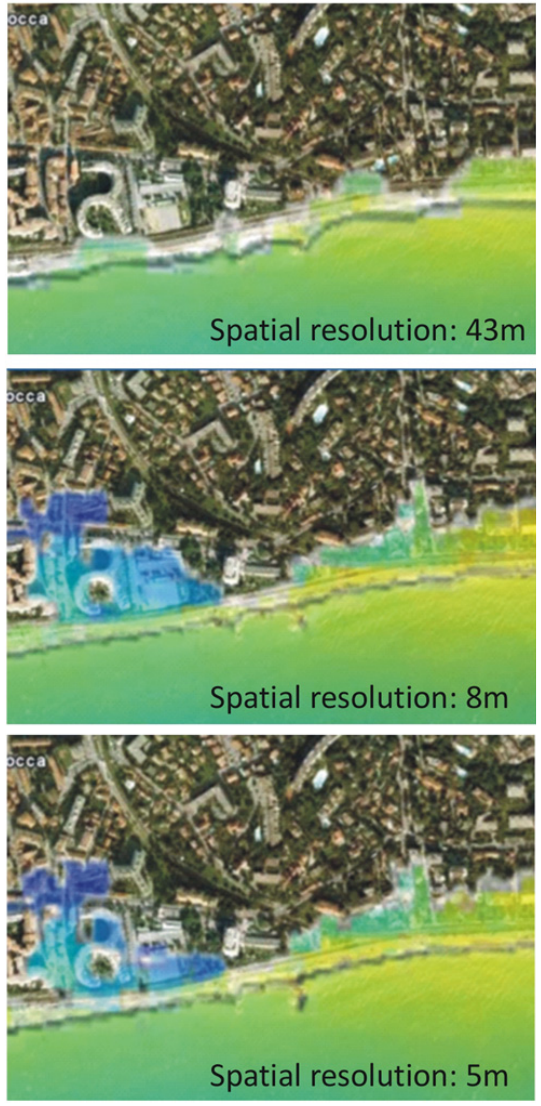
Fig. 3. Detail of the different inundations computed with the same initial conditions and input parameters, changing only the spatial resolution of the DTM (Cannes test site, south of France). Simula- tions have been performed with COMMIT (Cornell University), in the frame of the French ANR “MAREMOTI”